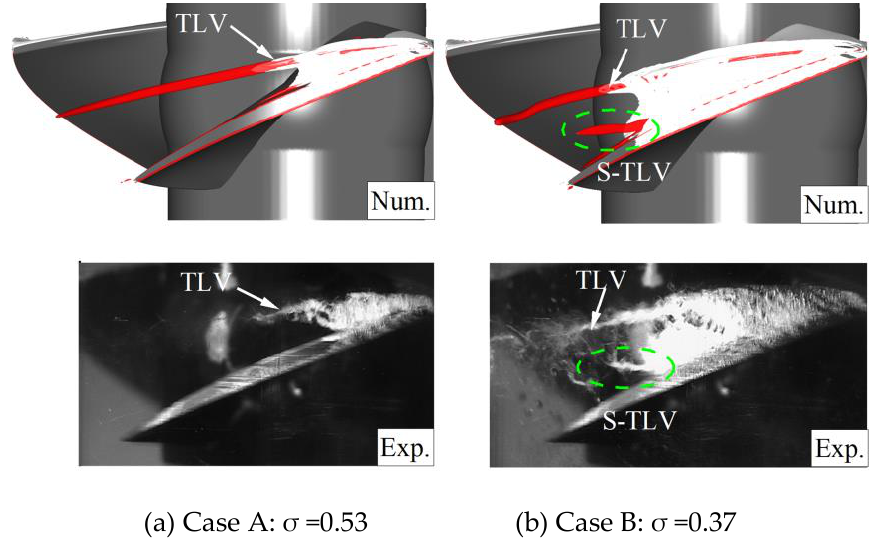
Figure 8. ( a – b ) Cavitation and vortex distributions under numerical simulation and experiment. Figure 8. ( a , b ) Cavitation and vortex distributions under numerical simulation and